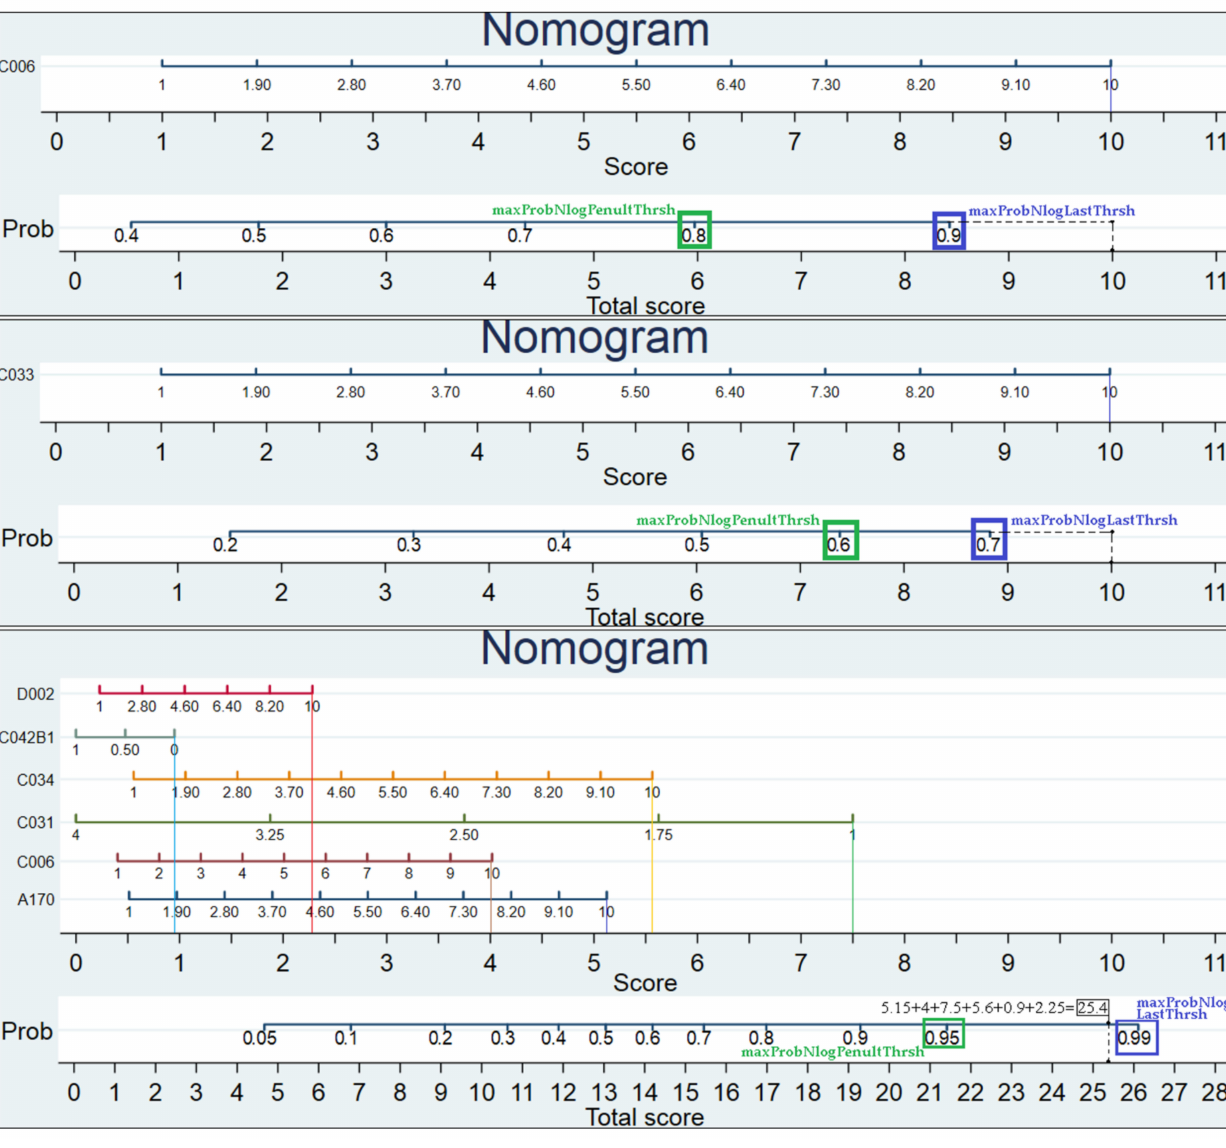
Figure A2. Illustration of the last two probability thresholds in the proximity of the model’s maximum theoretical probability using three nomograms for Table A3 (models 3 and 4) and Table A5 (model 1). Source: Own calculations using the nomolog command in Stata 17.0 MP 2021